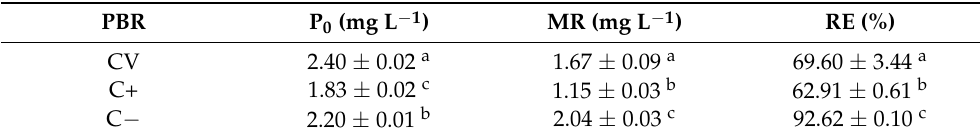
Table 3. Initial PO 4 –P concentration and removal parameters determined for each PBR: CV ( C. vulgaris + UWW), C+ ( C. vulgaris + autoclaved UWW), and C − (raw UWW). Values with a different letter within the same column are statistically different ( p < 0.05).